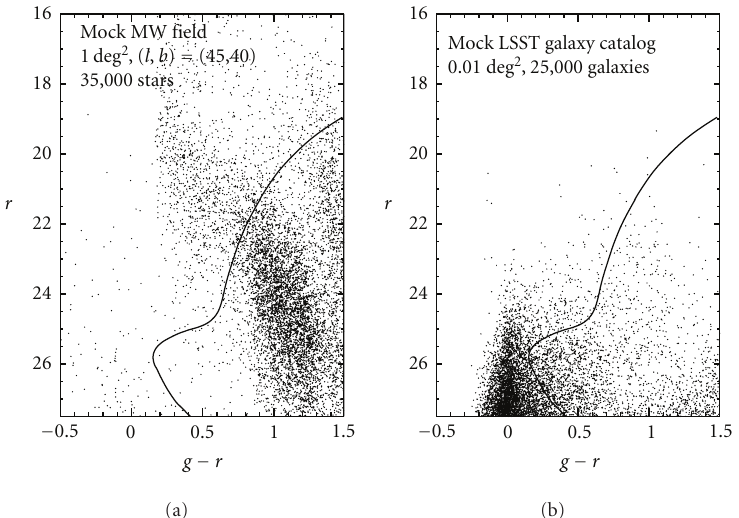
Figure 4: Simulated observations of Milky Way stars and galaxies in an LSST-like survey. (a) TRILEGAL simulated observation of Milky Way stars in a one deg 2 field at ( l , b ) = (45,40). (b) Simulated observation of galaxies in a 0.01 deg 2 field based on [69] (A. Connolly, private communication). A Dotter isochrone for a 10 Gyr, [Fe/H] = − 2 . 0 stellar population at a distance of 300 kpc ( m − M ∼ 22) is overplotted on both panels. For clarity, only 1/4 of sources in each panel are plotted. LSST-like photometric uncertainties have not been added to the simulated